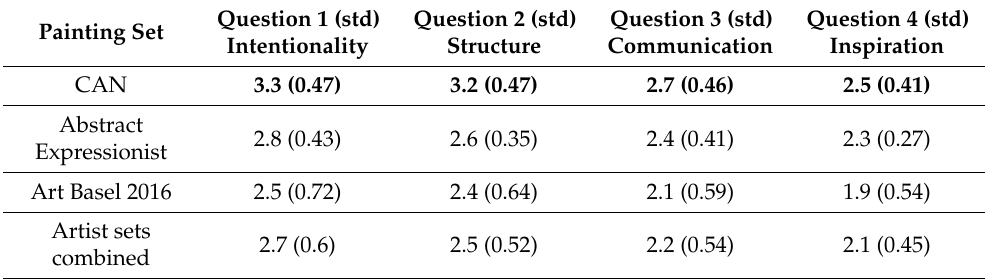
Table 9. Results of the subjective comparison of CAN against the datasets: Art created by human artists, Abstract Expressionist, Art Basel 2016, and the combination of the